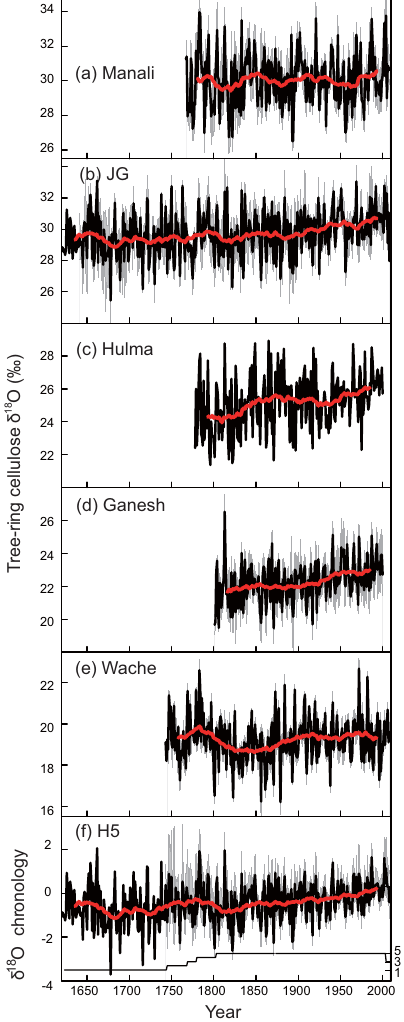
Figure 4. Tree-ring oxygen isotope chronologies from five sites (a– e) and the regional tree-ring oxygen isotope chronology (f) . Black line: mean values for all samples; red line: 31-year running average for the chronology; gray shading: the 95% confidence intervals for the local and regional